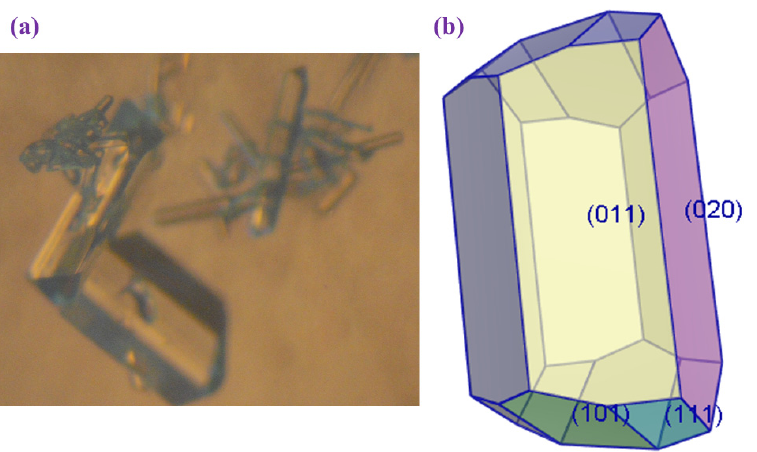
Figure 2. ( a ) Photograph of as grown (C 2 H 7 N 4 O) 2 BiCl 5 single crystal. ( b ) Theoretical morphology of (C 2 H 7 N 4 O) 2 BiCl 5 crystal based on the BFDH law.